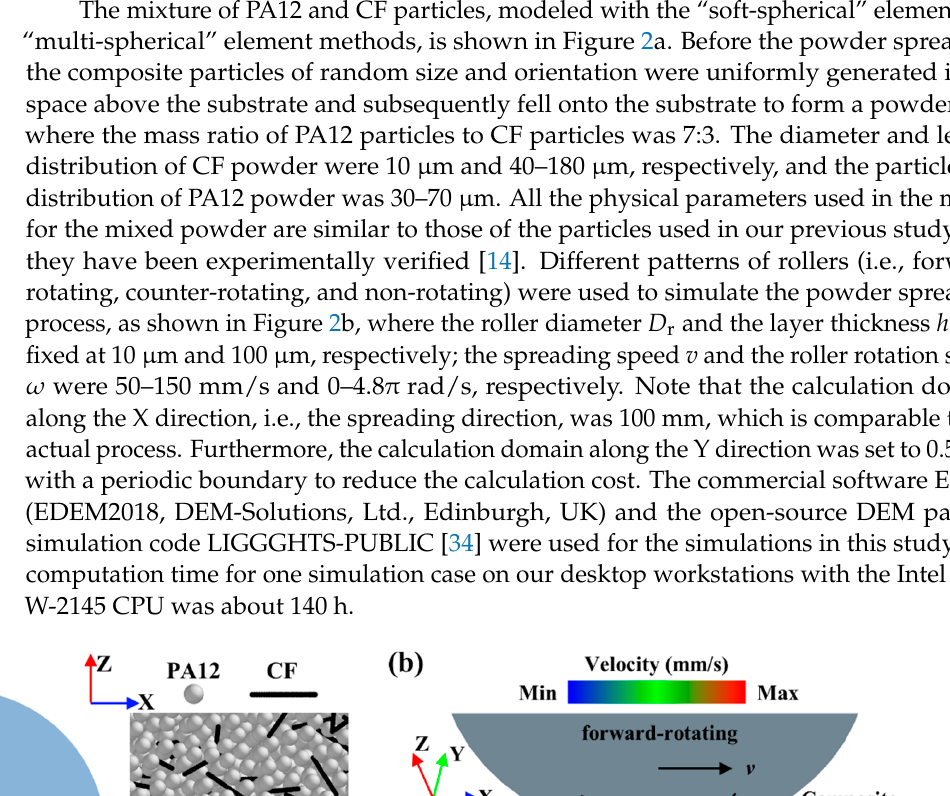
Table 1. Processing parameters employed in the simulations.